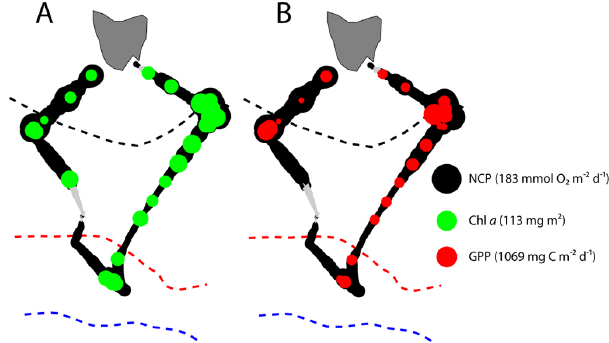
Fig. 4. Mixed-Layer NCP vs. (A) Chl- a (green) (B) depth inte- grated 14 C primary production (red). The diameter of the filled red and green circles indicates the magnitude of the 14 C production and Chl- a values. Legend shows the largest corresponding values. Pos- itive and negative NCPs are represented by black and grey symbols, respectively, such that the thickness of the band in each figure is proportional to the continuous NCP measurement. Negative NCP values could result from vertical mixing of O 2 undersaturated wa- ters. The black, red, and blue dashed lines represent the climato- logical positions (Orsi et al., 1995) of the Subtropical, Subantarctic, and Polar fronts,